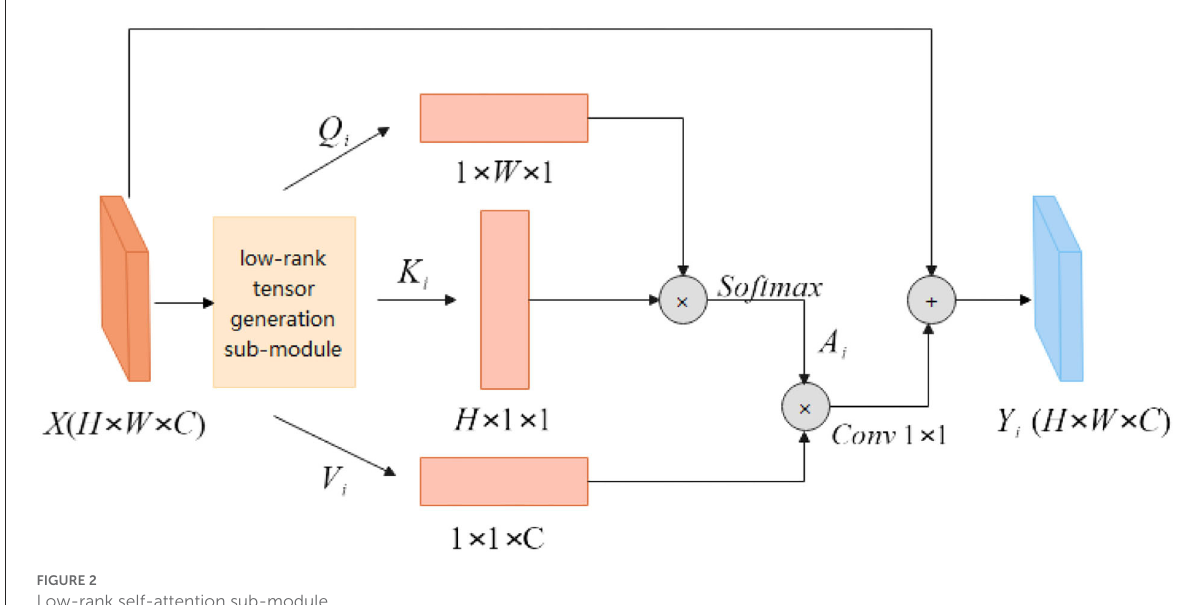
FIGURE2 Low-rank self-attention sub-module.